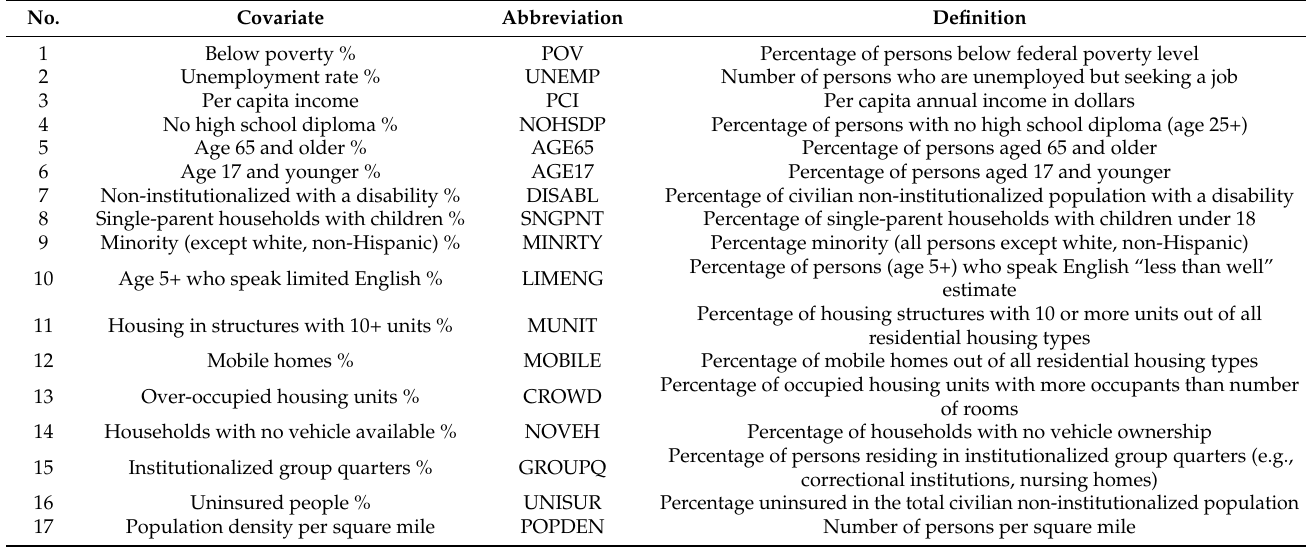
Table 1. The covariates used in this study